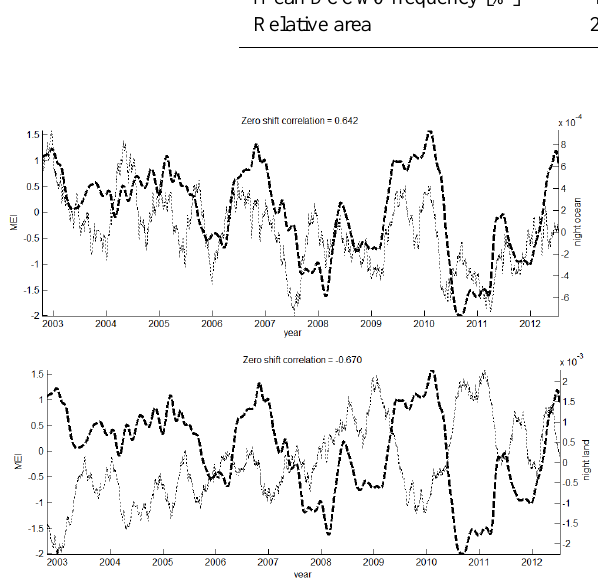
Figure 7. The DCCw0 anomaly (light dots) and the MEI (heavy trace), smoothed with a 96-day running 687 Fig. 7. The DCCw0 anomaly (light trace) and the MEI (heavy average. The top panel presents ocean night, the bottom panel presents land night. 688 trace). Top panel presents ocean night. Bottom panel presents land night.